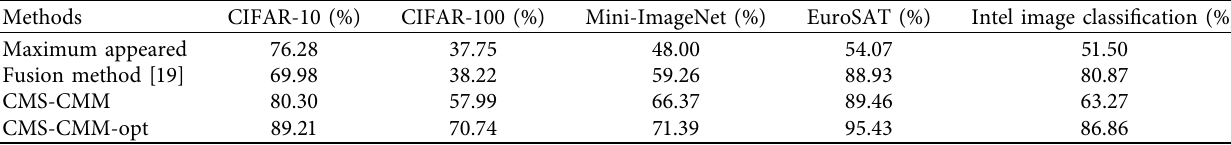
Table 2: Evaluation based on CDCL (the accuracy of predicting correct domains and correct labels).